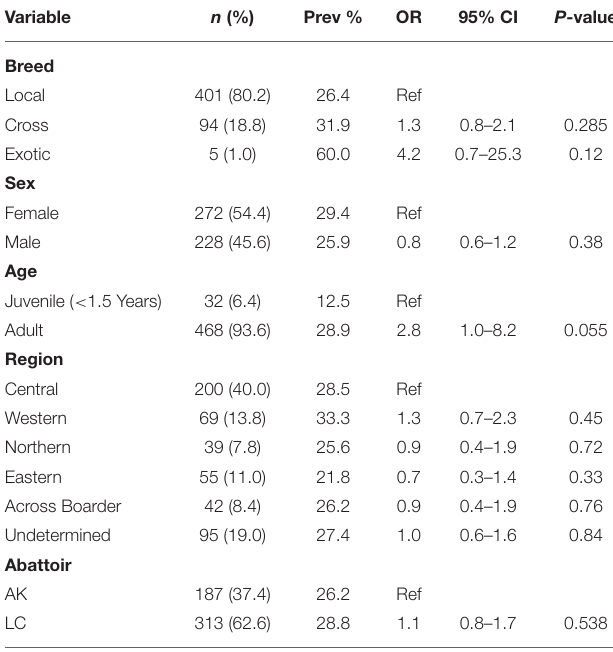
TABLE 2 | Population characteristics of the sampled slaughter cattle ( N = 500), Leptospira seroprevalence and associated risk factors as calculated by univariable logistic